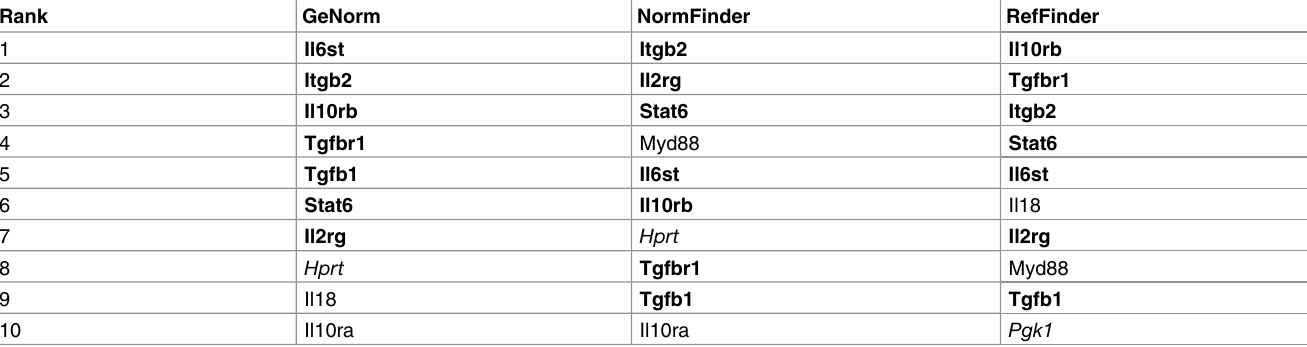
Bold letters indicate those genes that were identicalamong the top-tenby the three methods. Italics indicate “traditional”reference genes according to